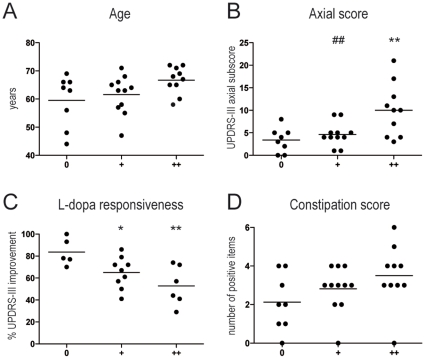
Correlation of clinical symptoms with pathology burden.
A. Measure of pathology burden using a quantitative score correlated with age, which appeared as a potential confounding factor. Subsequent correlation analysis was performed after adjusting the data for age. B. Pathology burden positively correlated with axial score, which measures axial symptoms such as dysarthria and postural instability. The group with severe pathology (++) significantly differed from the group with absent (0) or moderate (+) pathology (p<0.01). C. Pathology burden also correlated with L-Dopa responsiveness, estimated by the percentage of UPDRS-III improvement after L-Dopa intake. Responsiveness was higher in the group with absent pathology (0), as compared with the group with moderate (+, p<0.05) or severe (++, p<0.01) pathology. D. Pathology burden also correlated with constipation severity, as defined by the number of positive answers to the constipation items of Rome III questionnaire. Each black circle represents one PD patient. Horizontal bars represent the mean. *p<0.05 and **p<0.01 as compared with the group with absent pathology (0). #p<0.05 and ##p<0.01 as compared with the group with severe pathology (++).